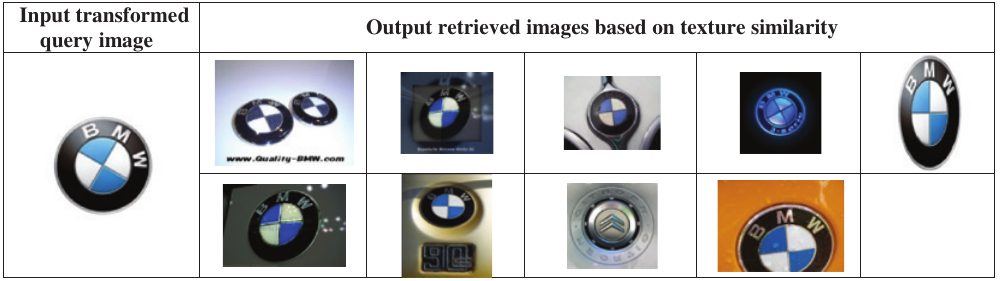
Table 3: Final Output Retrieved Images Based on Texture Similarity.